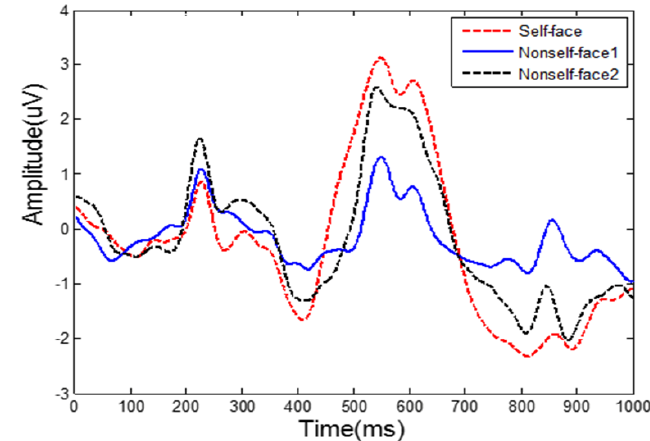
Figure 3. The grand ERPs evoked by self-face and non-self-face at electrode P4.